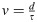
Relation between the trip duration and the distance traveled by bike users in Chicago and New York.In (a) and (b), we present hexagonally binned two-dimensional histograms for the logarithm of τ/τ0 and the logarithm of the corresponding quantity d/d0 where τ0 = 1s and d0 = 1Km are reference values. The colors codified in the colorbar represent the number of travels f(τ, d) found in each hexagonal bin. For the results in both cities, the dashed lines depict the relation d = v⋆τ where v⋆ is an effective speed (v⋆ = 10 Km/h for Chicago and v⋆ = 9 Km/h in New York). This relation is explored in (c) where we analyze the values of the average speed v=dτ for each of the trips. We obtain the probability density p(v) by using linear bin counts with size Δv = 0.05 Km/h. Our findings reveal marked peaks for the values of the speed that appear with high probability in each city and coincide with the value v⋆ reported in (a) and (b).